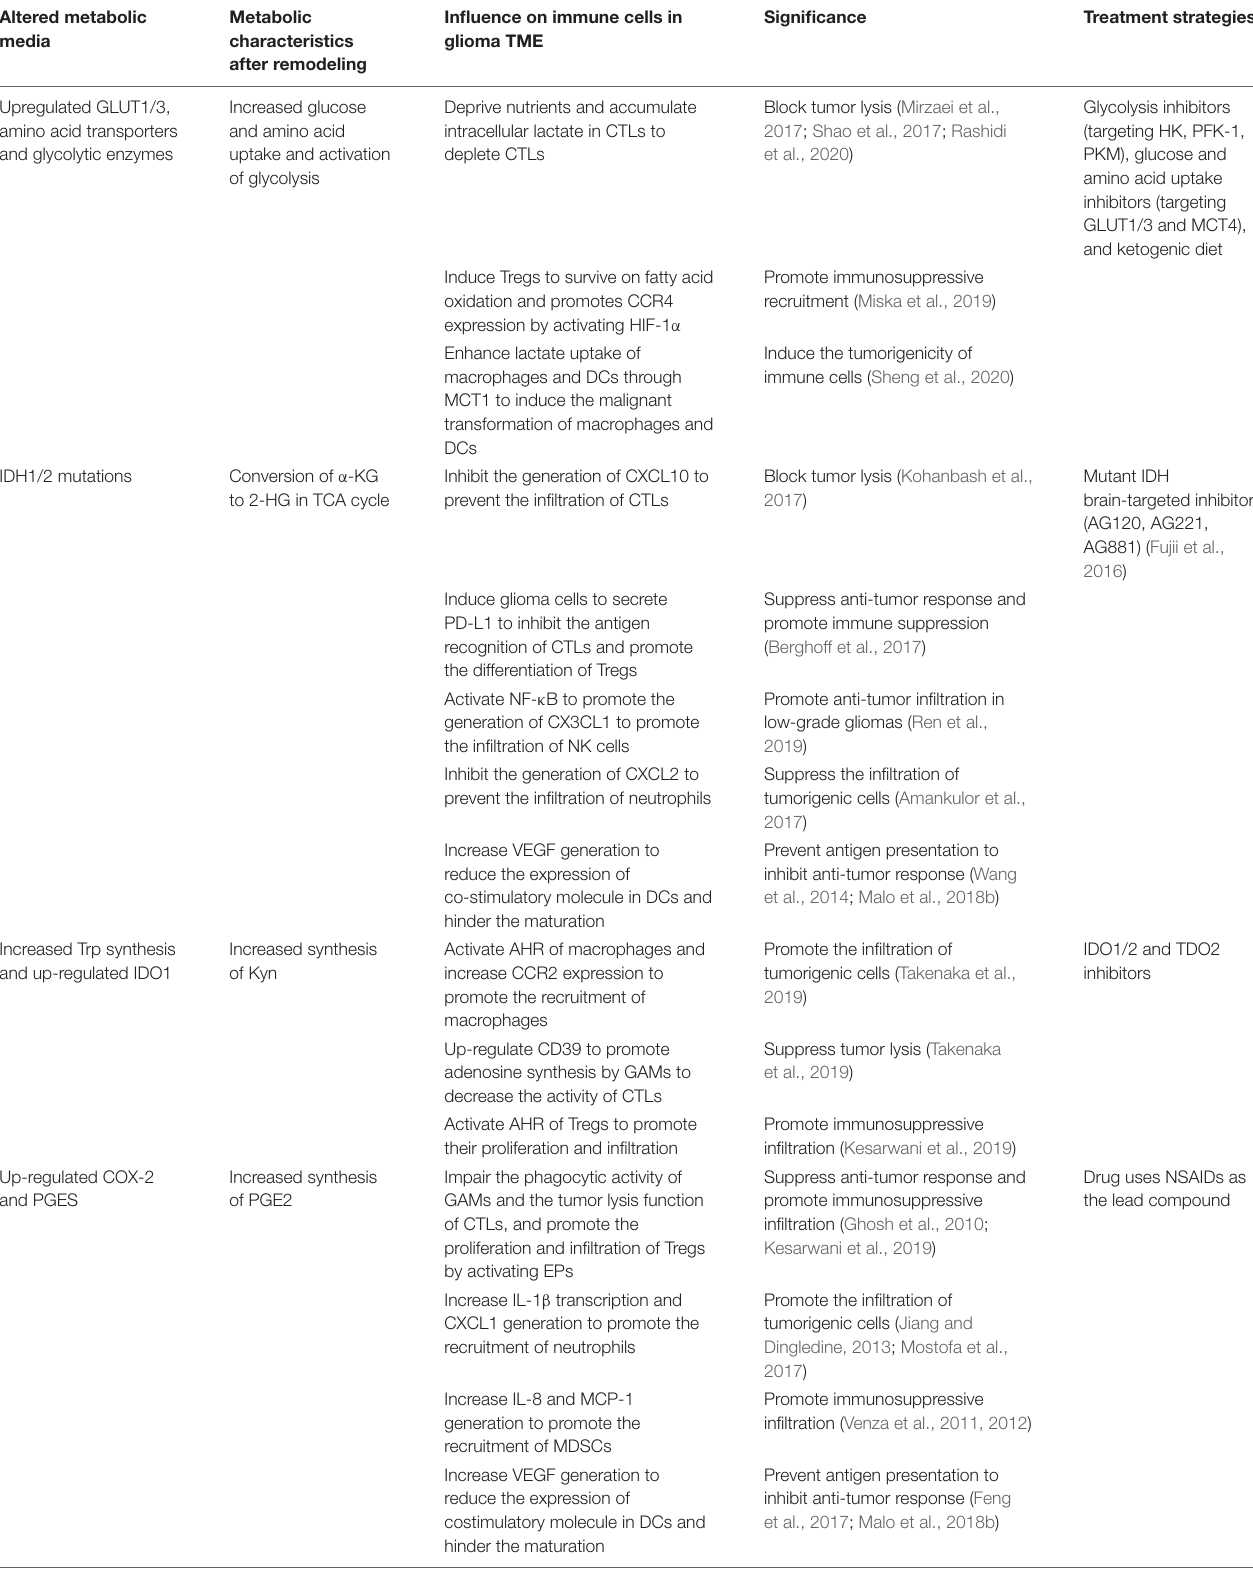
TABLE 2 | The impact of metabolic remodeling of glioma cells on immune